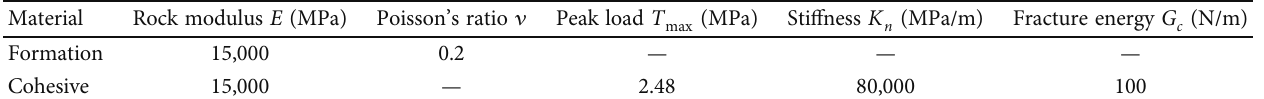
Table 1: Input variable values.